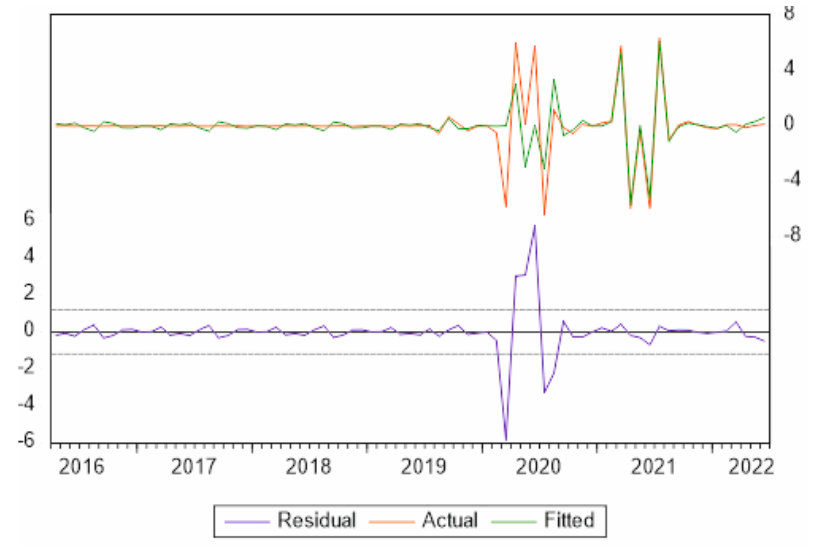
Figure 5. Monthly evolution of the number of gastronomic tourists in C ó rdoba and estimation errors (January 2015 to June 2022). Source: own elaboration based on ARIMA model